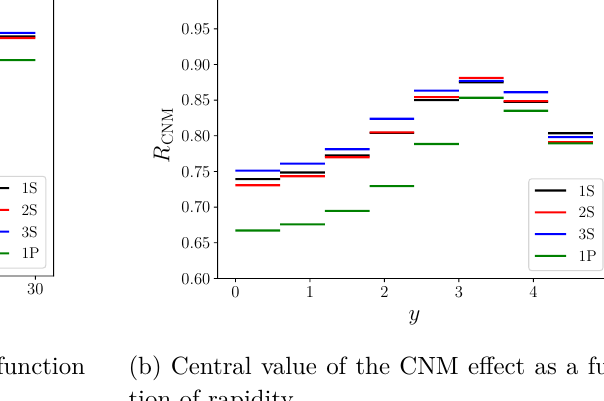
of transverse momentum.